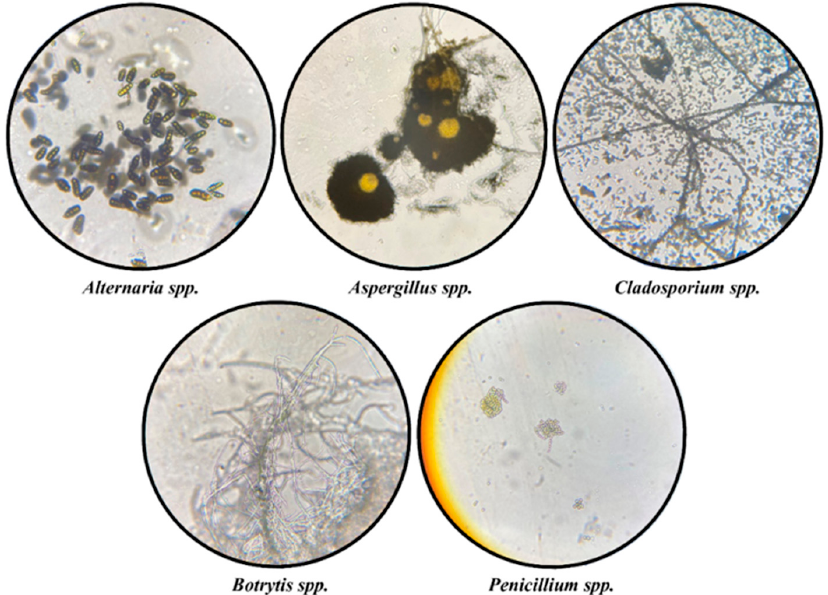
Figure 6. Appearance of the fungal colonies taken from the indoor air in Darvas-La Roche House on the seventh day of incubation.